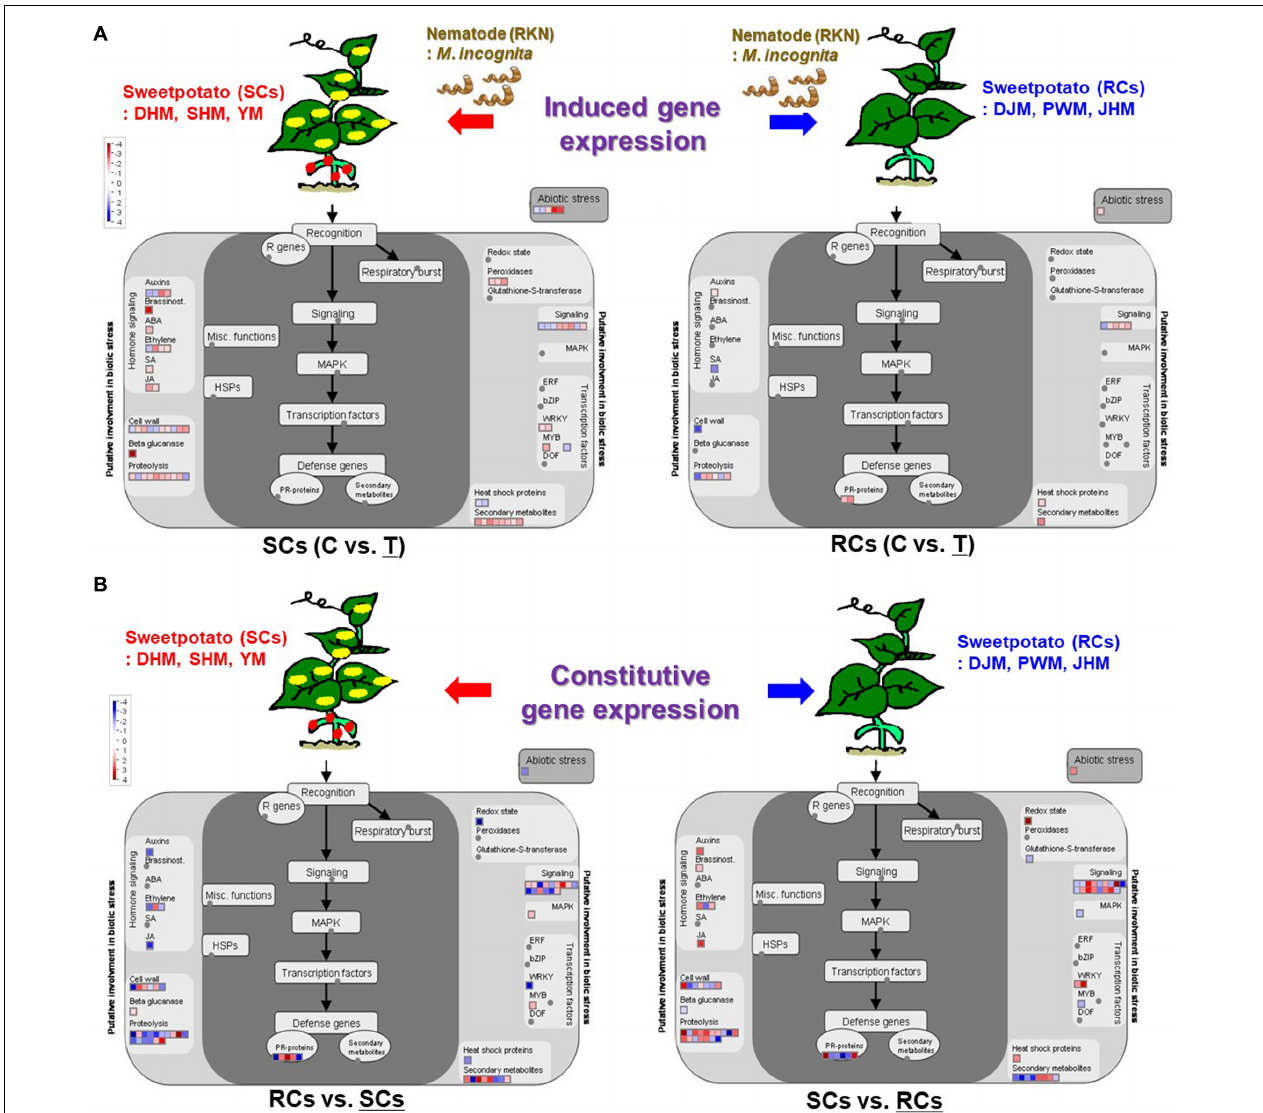
FIGURE 11 | MapMan diagram of sweetpotato genes involved in induced defense and constitutive defense response to M. incognita infection in SCs (left) and RCs (right). (A) Induced defense response to M. incognita infection in sweetpoato. (B) Constitutive defense response to M. incognita infection in sweetpoato. An overview of gene expression patterns (log 2 FC) in infected plants relative to the untreated control is shown. Dots indicate the different paralogous genes encoding proteins related to a certain step in the defense response. Red dots indicate upregulation, blue dots indicate downregulation and gray dots indicate no response. DHM, Dahomi; DJM, Danjami; PWM, Pungwonmi; SHM, Shinhwangmi; JHM, Juhwangmi; YM, Yulmi; RCs, resistant cultivars; SCs, sensitive cultivars; C, control; T,